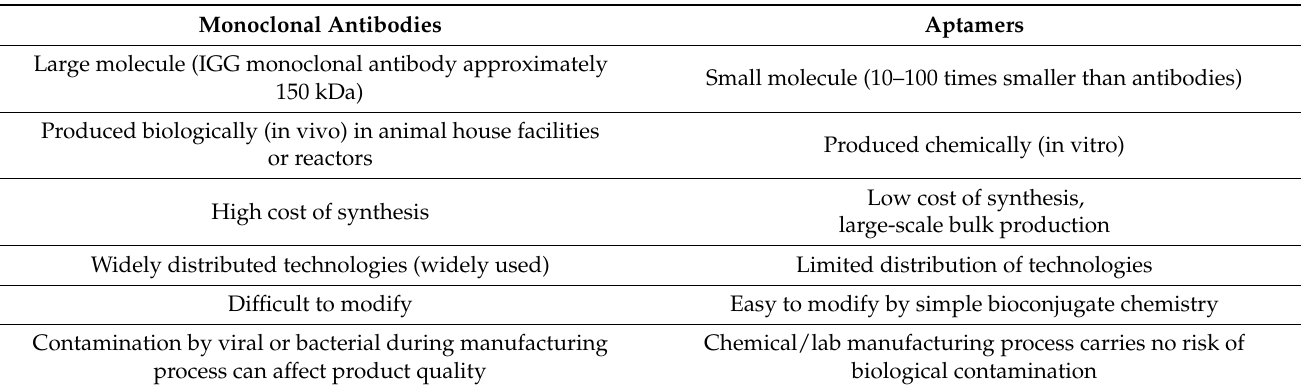
Table 1. Comparison of the critical properties of antibodies and